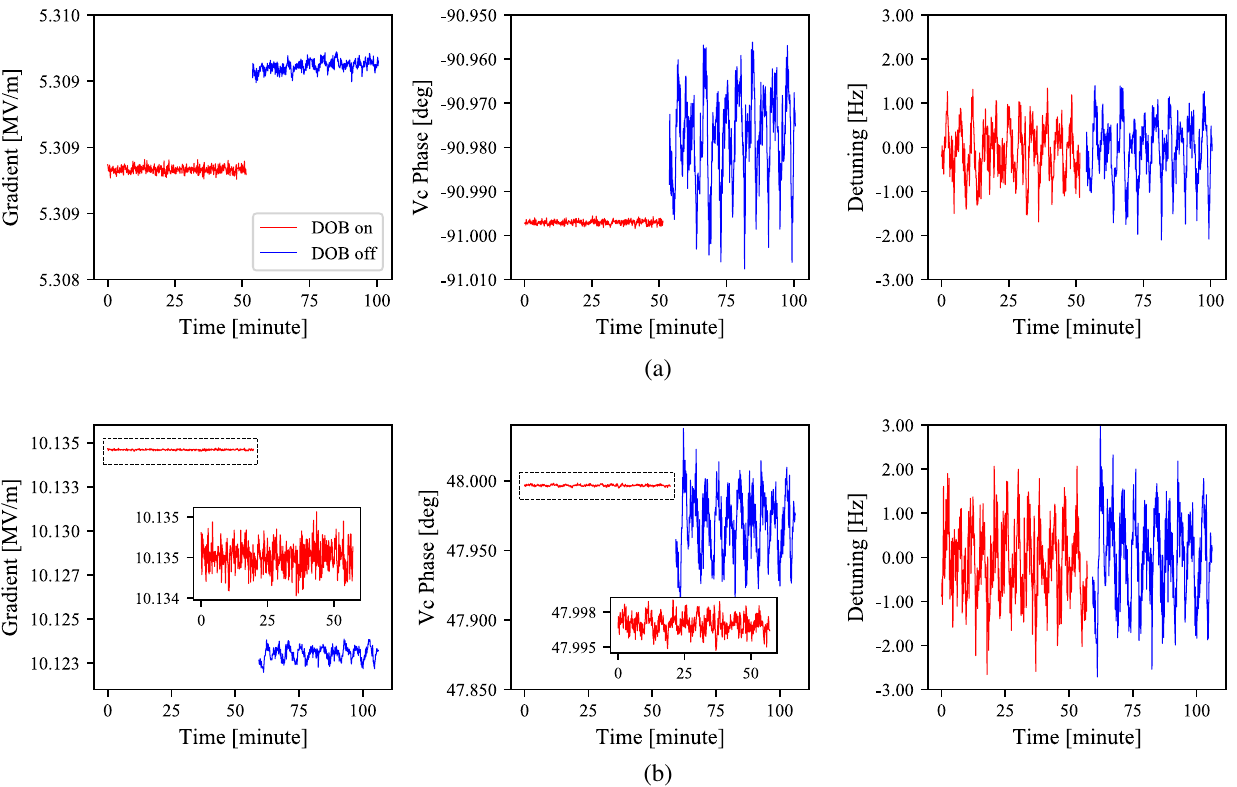
FIG. 20. Pulse to pulse stabilities of (a): ML1 ( V c ¼ 5 . 5 MV) and (b) ML2 ( V c ¼ 10 . 5 MV) in the case of P control (blue) and P þ DOB control (red) with 5 kHz Q filter in the absence of the